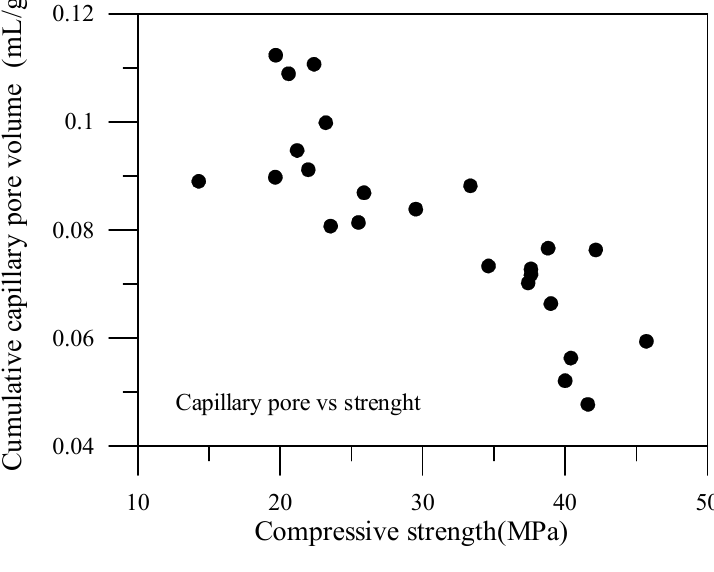
Figure 21. Compressive strength vs. capillary pore of specimens with mineral